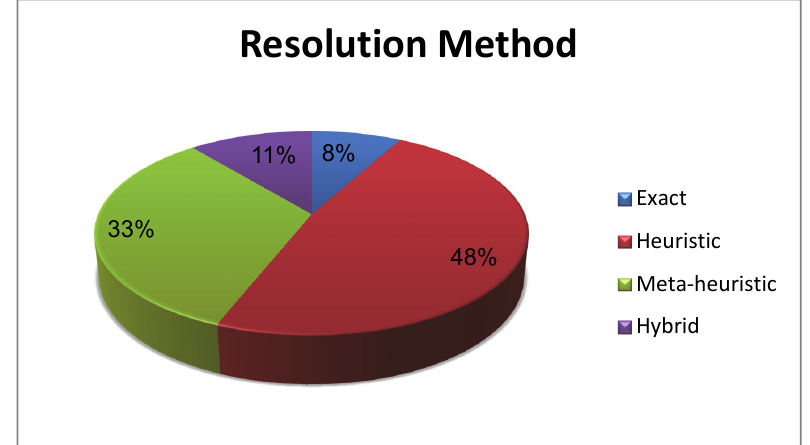
Fig. 3. Resolution methods used in flexible flow shop